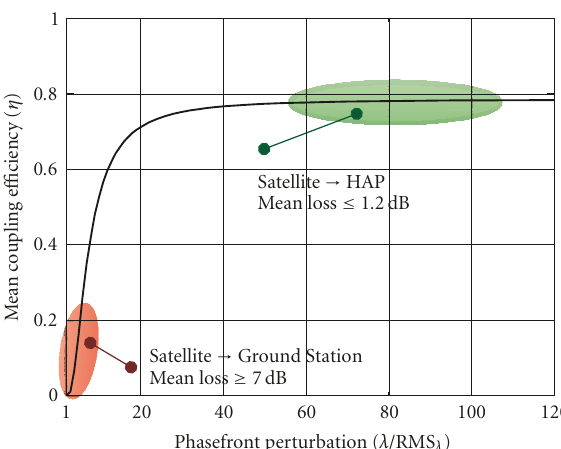
Figure 5: Mean coupling e ffi ciency (cid:4) η (cid:5) for a standard single-mode fiber as a function of the rms phasefront perturbation RMS λ given in fractions of the wavelength λ.